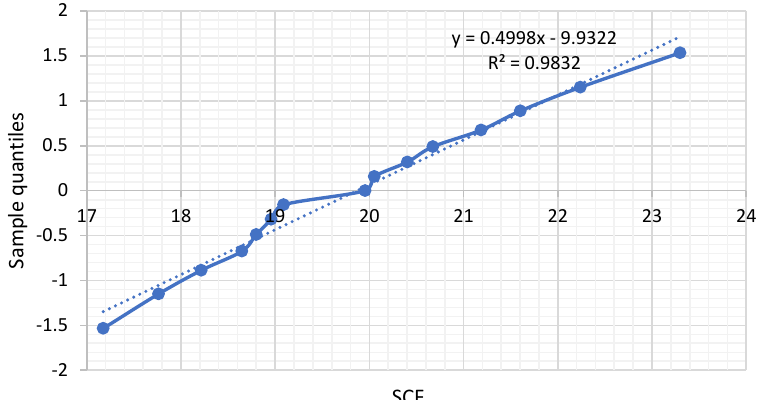
Figure 9. SCF values from experimental work plotted in a normal distribution paper, indicating a mean value of the SCF of 19.87 and a standard deviation of 2.